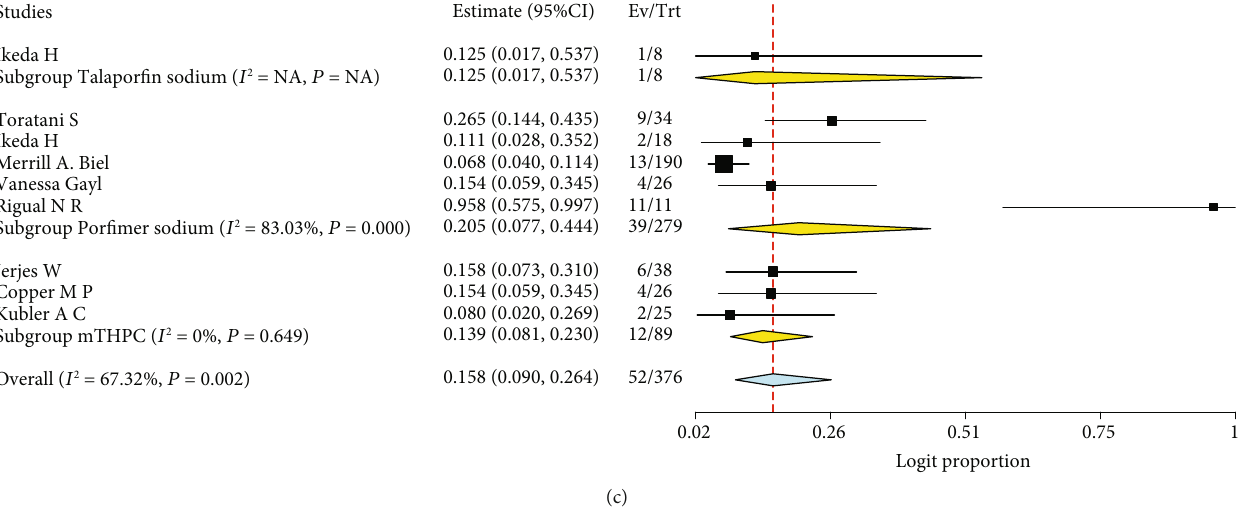
Figure 6: Forest plot of subgroup analysis of (a) CR, (b) OR, and (c) RR in cases using di ff erent types of